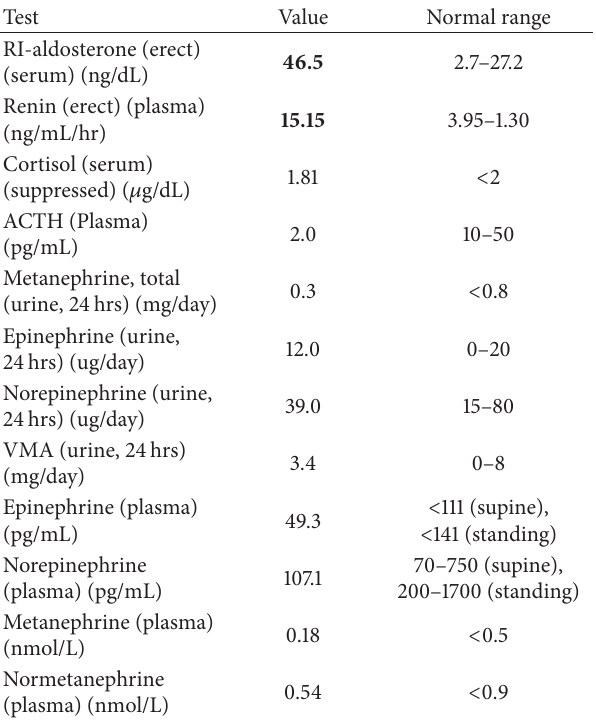
Table 1: Data of endocrine